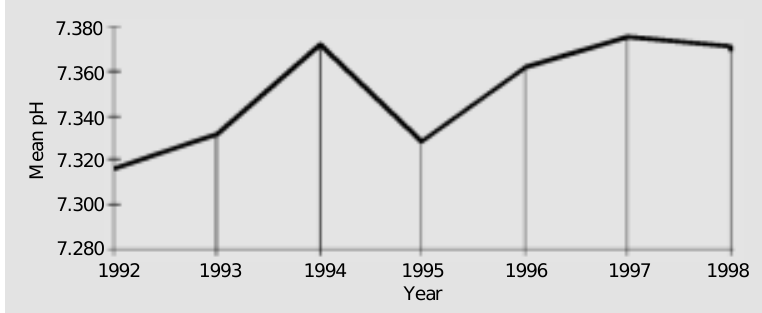
Figure 4. pH values